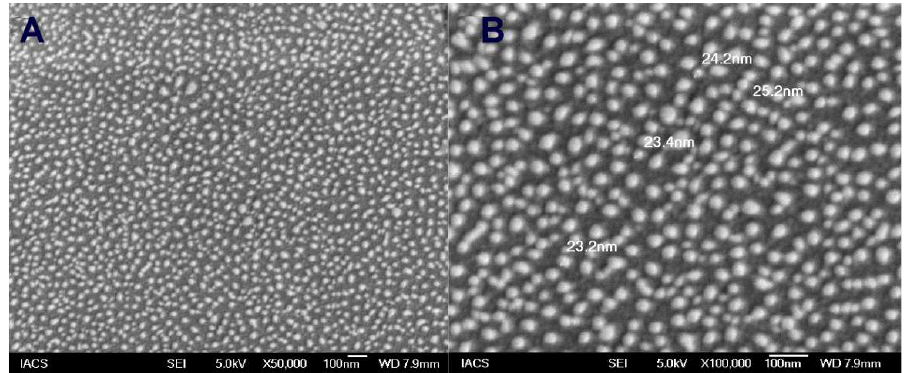
Figure 1. FESEM images of ( A ) tamoxifen citrate loaded nanolipid vesicles; ( B ) antibody conjugated tamoxifen citrate-phosphoethanolamine nanolipid vesicles.